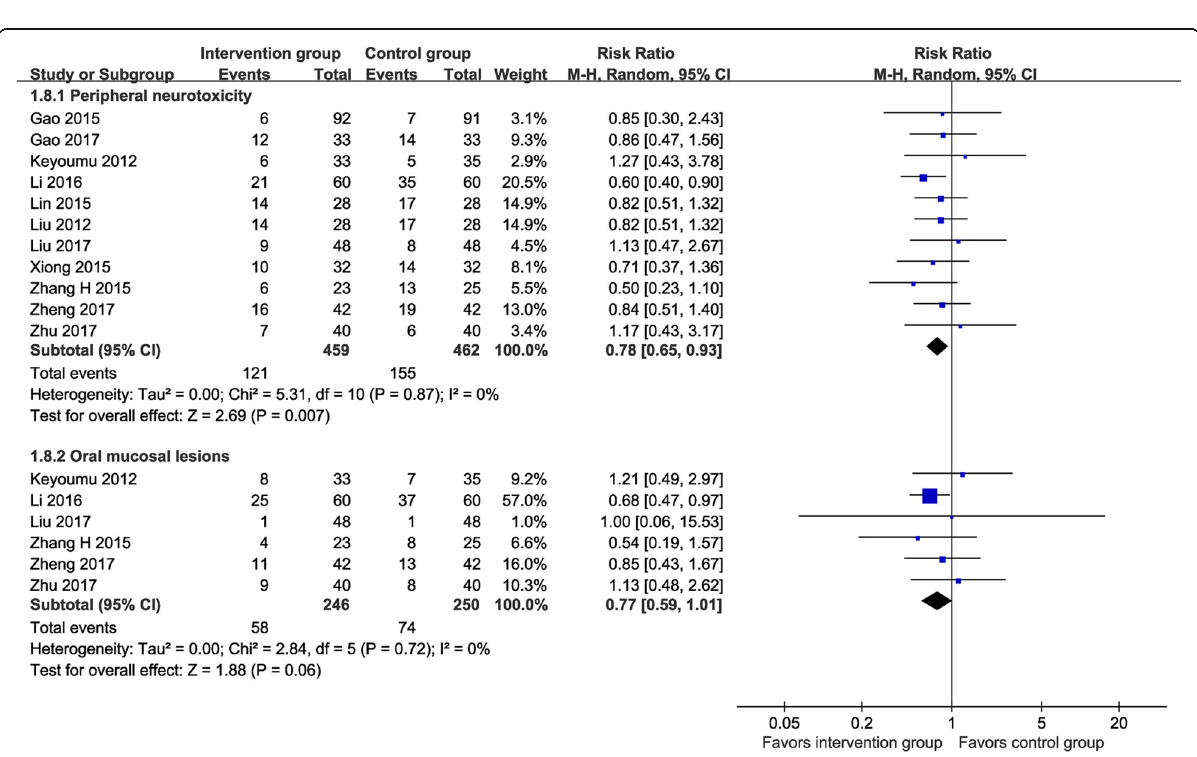
Fig. 10 Meta-analysis on incidence of peripheral neurotoxicity and oral mucosal